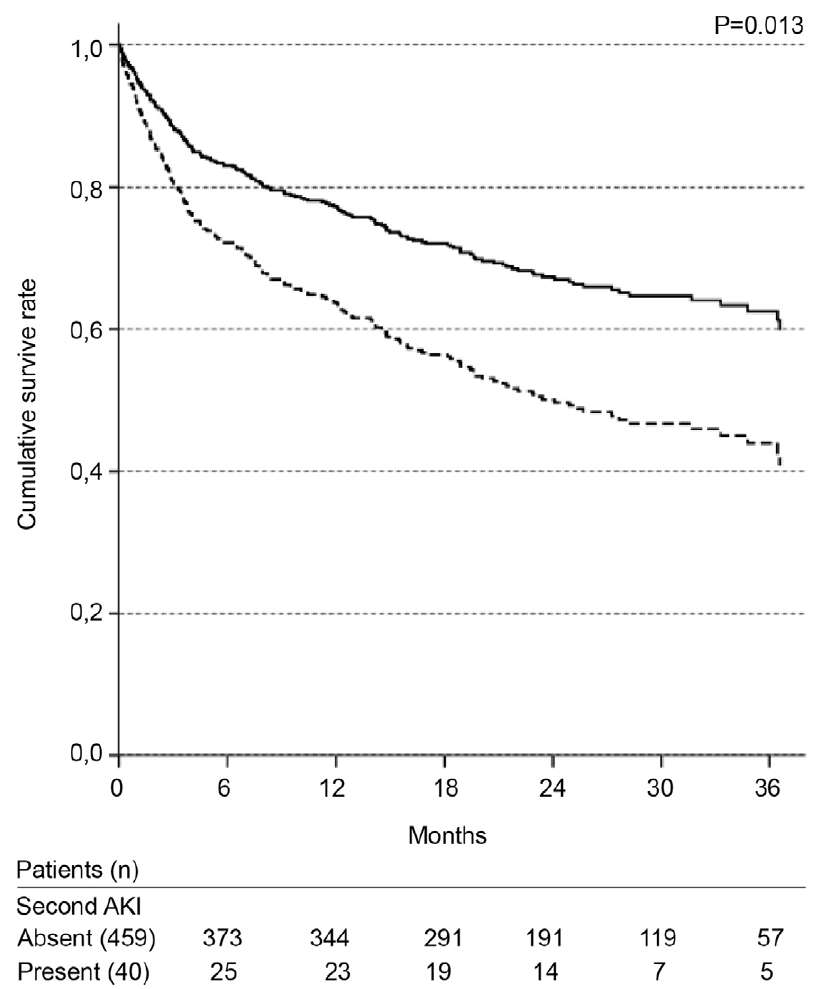
Figure 6. Cox survival curves according to the presence of a second AKI episode during the same hospitalization. Solid line: absence; dotted line: presence. Adjusted for: gender; age; presence of cancer, heart failure, and presumed chronic kidney disease; nephrotoxic and septic etiologies.